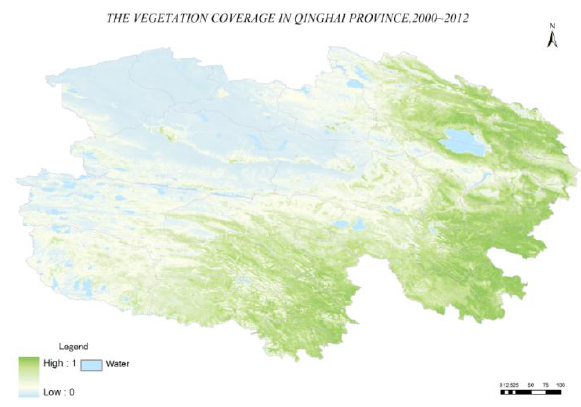
Figure 1. The average of annual maximum vegetation coverage during the period from 2000 to 2012 in Qinghai province